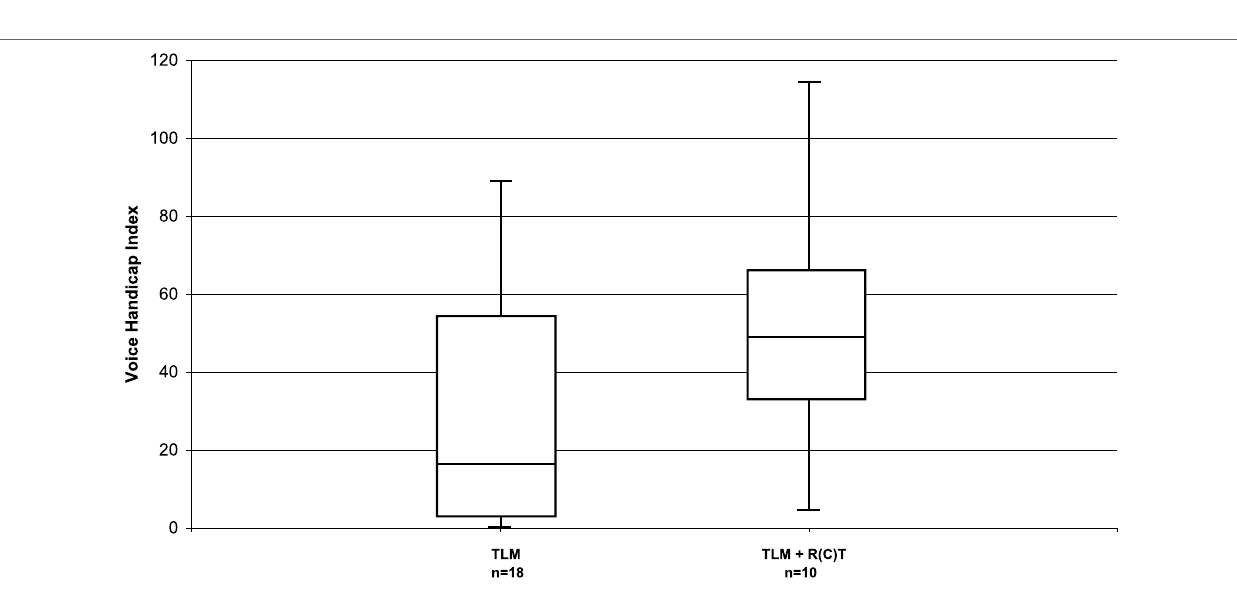
FigUre 2 | Distribution of the VHI in long-term survivors after TLM ( n = 18) and after TLM + adjuvant RT ( n = 10).